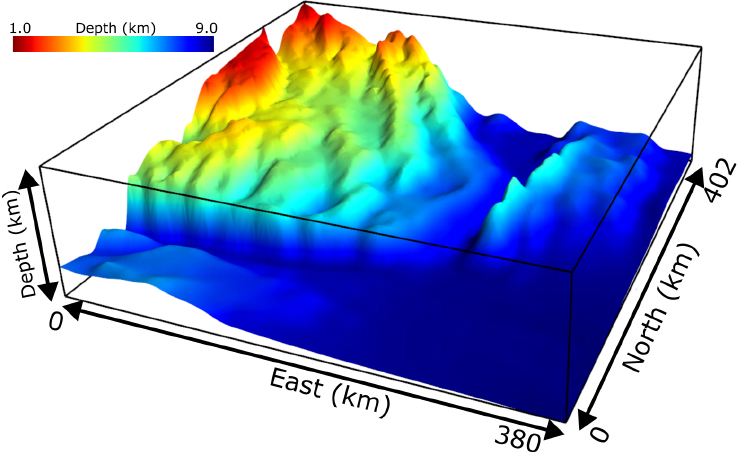
Figure 3. Bishop basement example for gravity data inversion by depth in